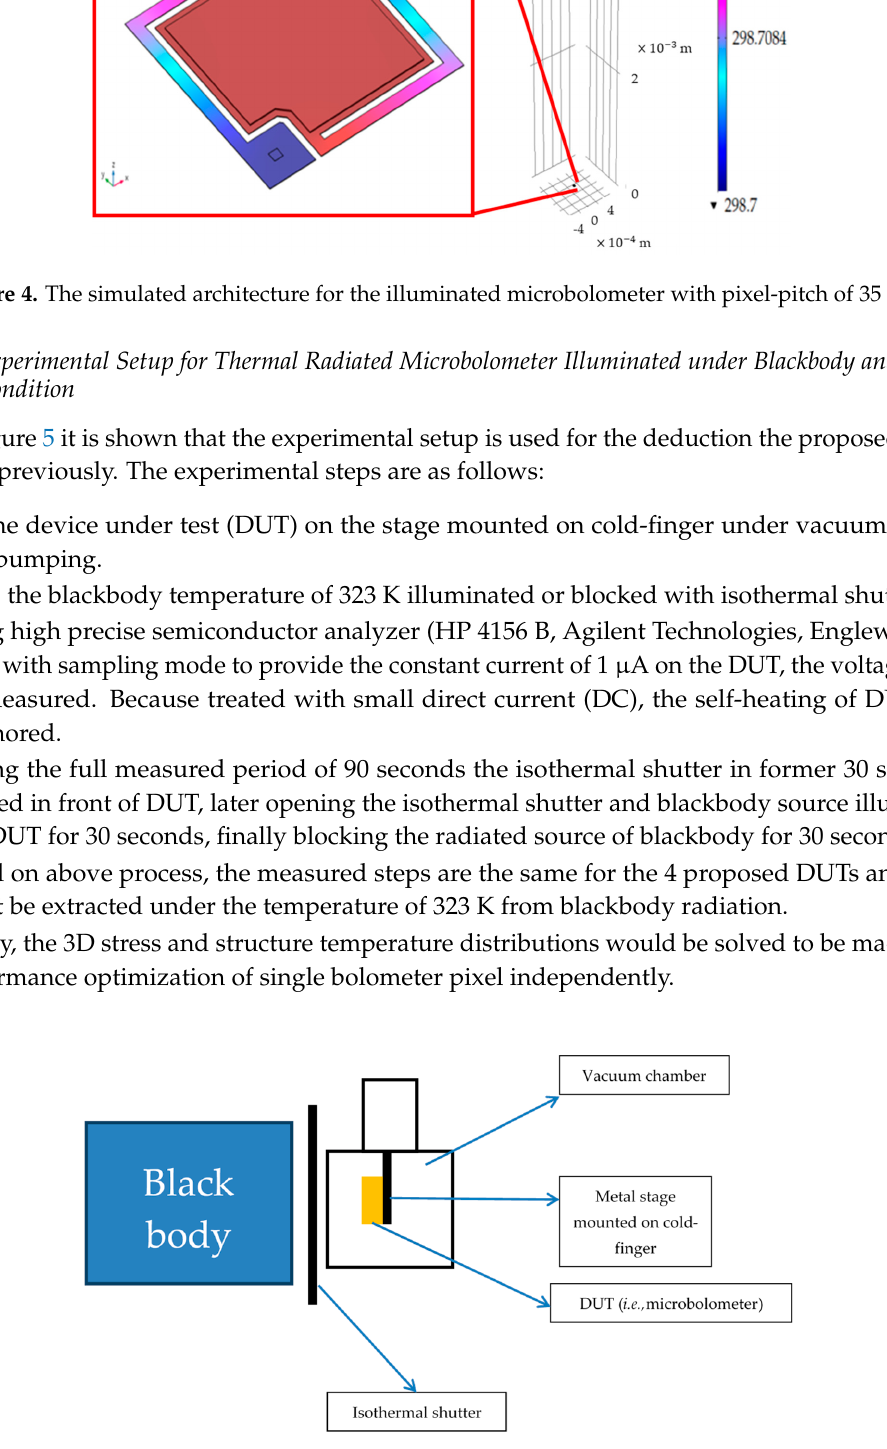
Figure 5. The experimental setup for the thermal radiation on the 4 different microbolometer structures.